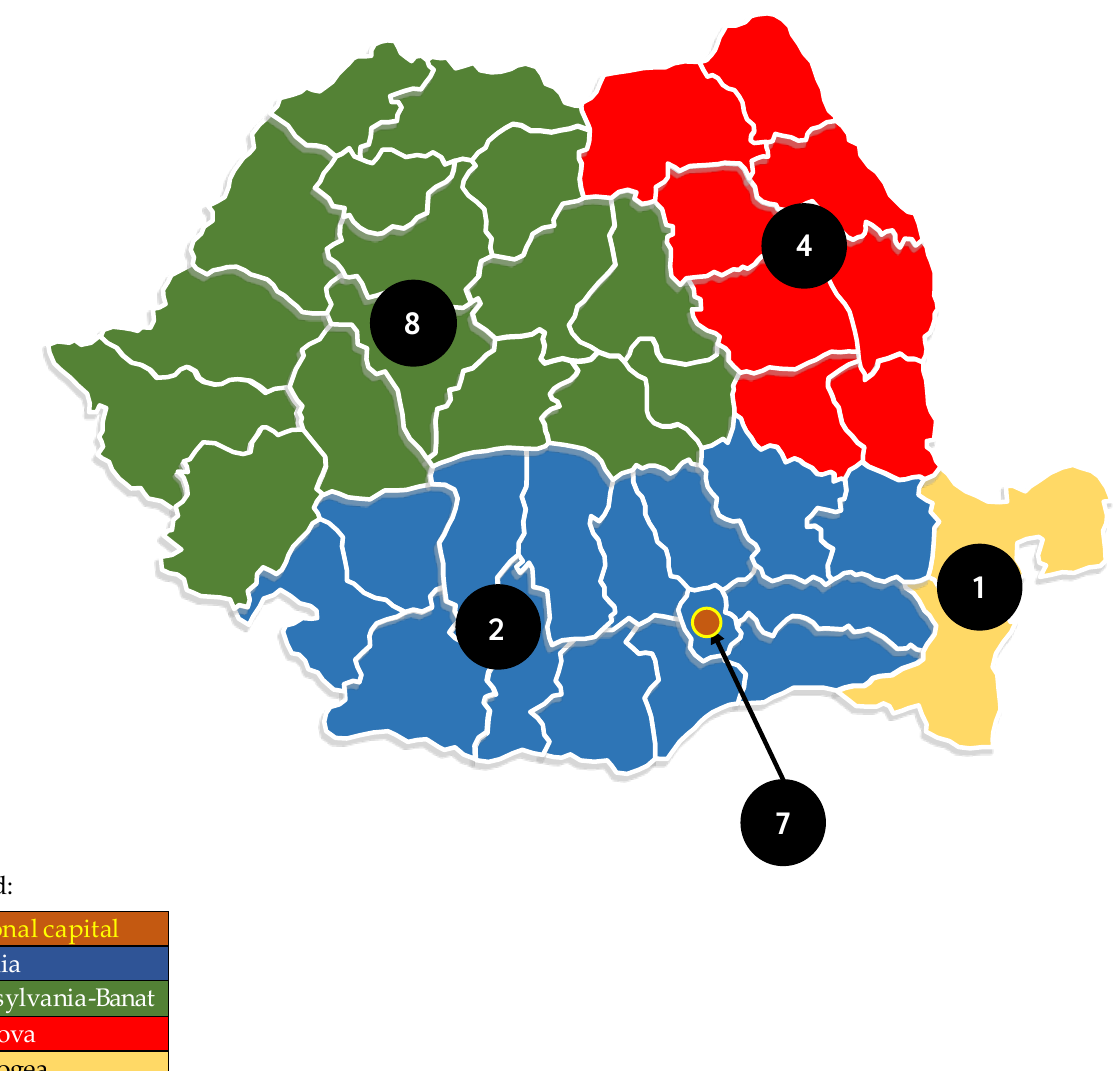
Figure 1. Number of journals by historical region.